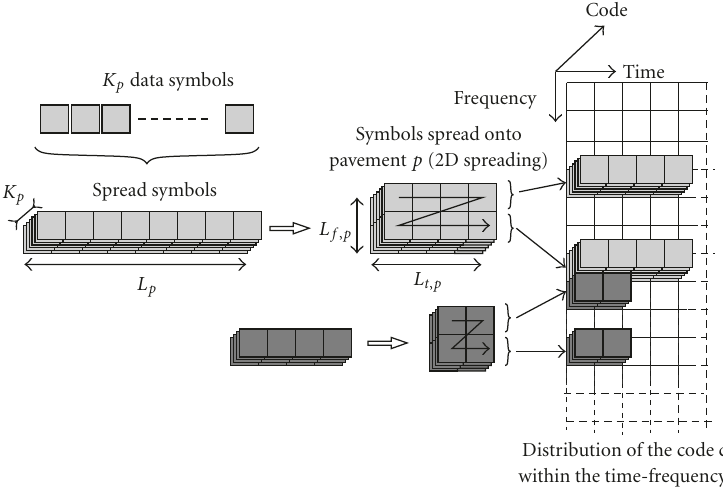
Figure 1: Schematic representation of the 2D-spreading